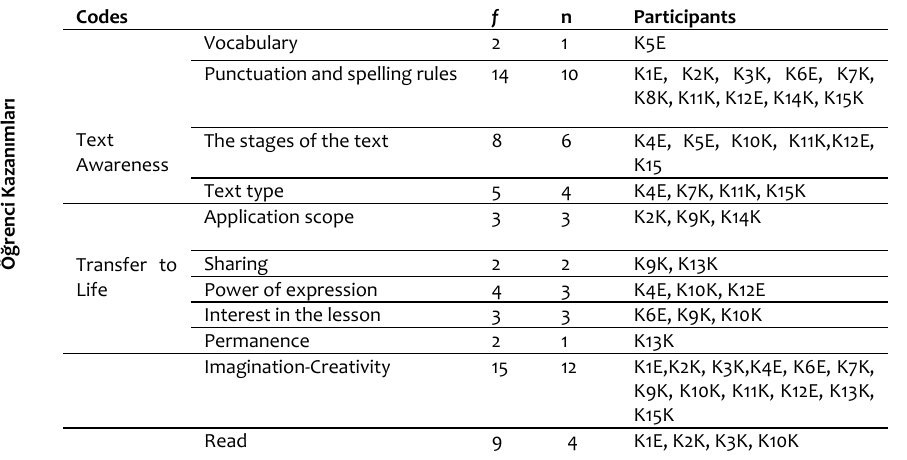
Table 5. Findings Regarding the Theme of Student